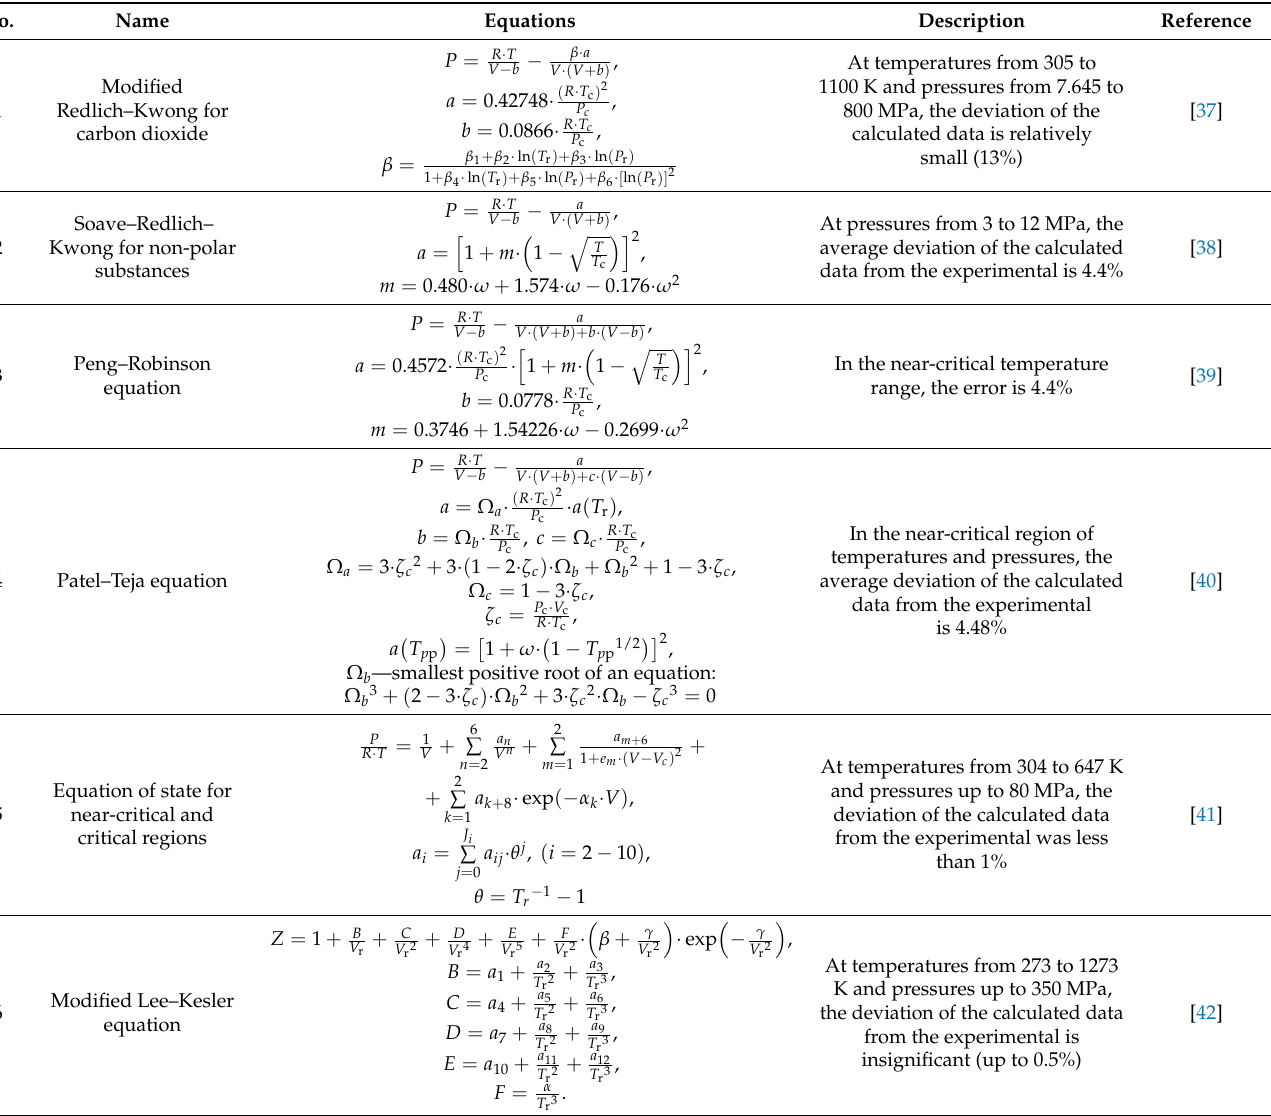
Table 1. List of equations of state suitable for calculating the thermodynamic characteristics of substances under sub- and supercritical